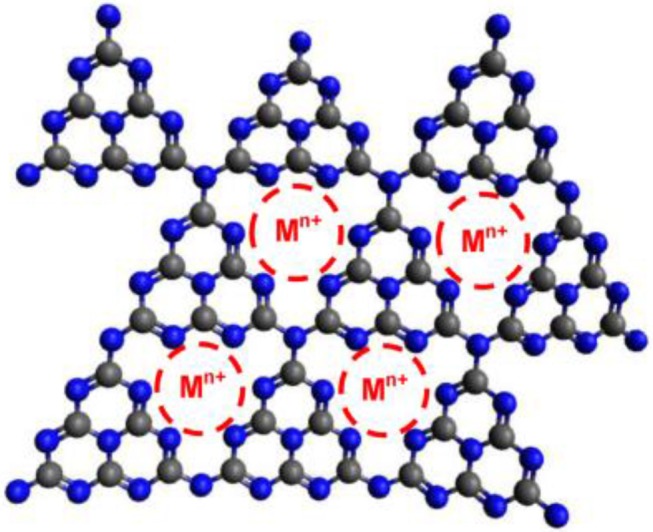
Schematic structure of g-C3N4 framework with obtaining metal ion (Ong et al., 2016). Copyright 2016, American Chemical Society.